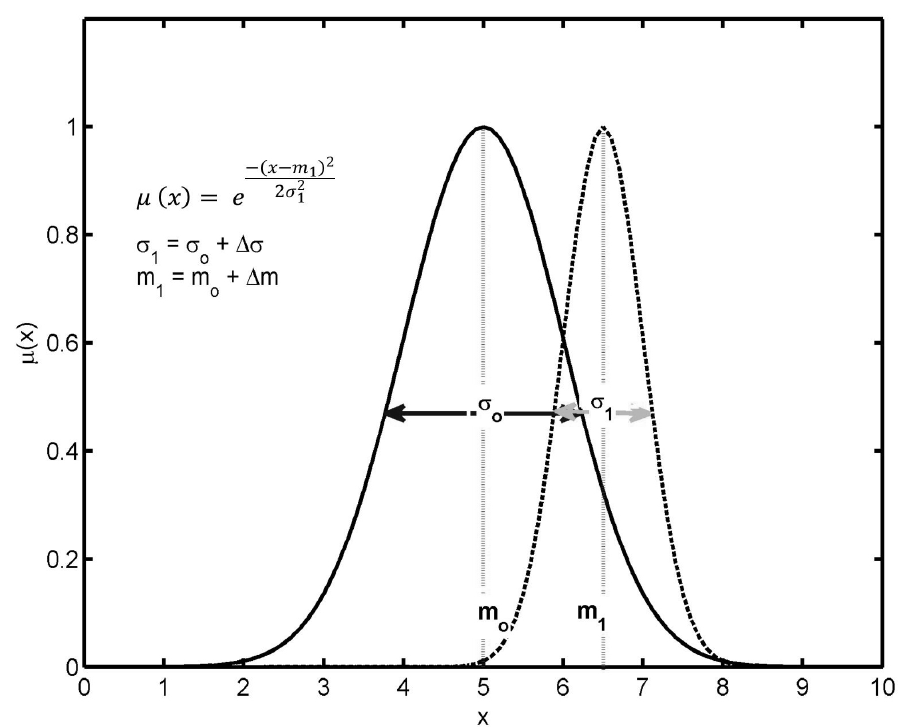
Figure 2. The Gaussian MFs updating principle.